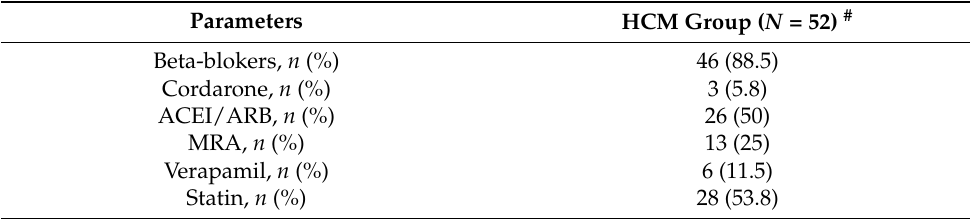
Table 4. Pharmacological treatment of patients with